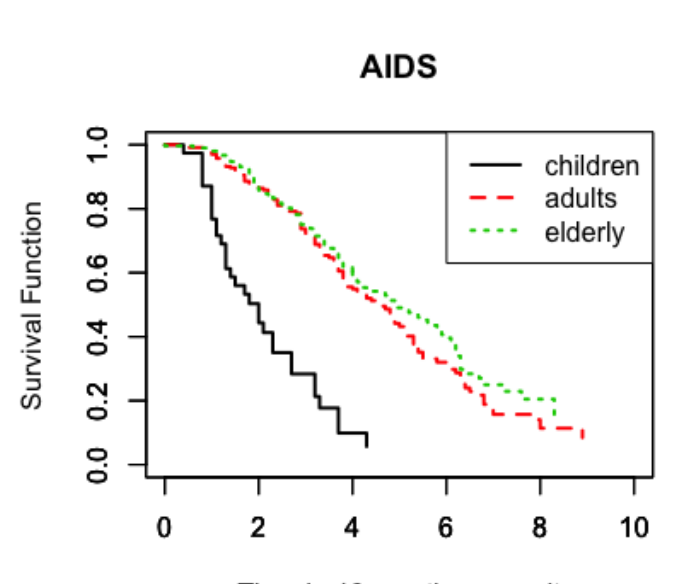
aged 0–4 years as child patients, 119 observations aged 5–59 years as adult patients,